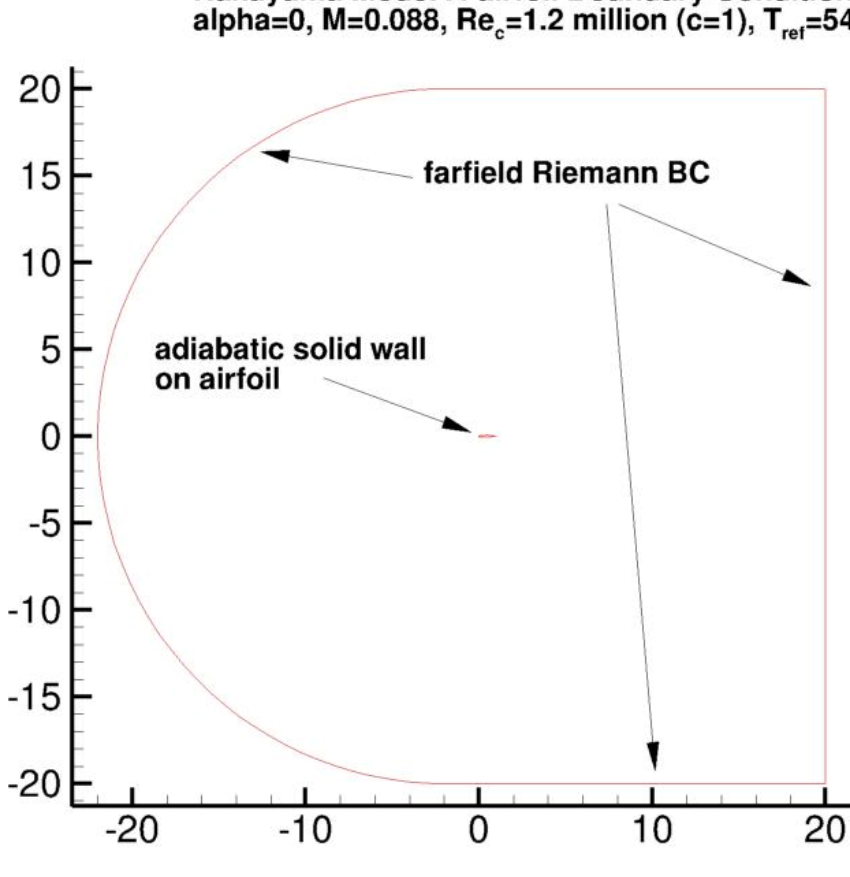
Figure 10. Airfoil boundary conditions [20].